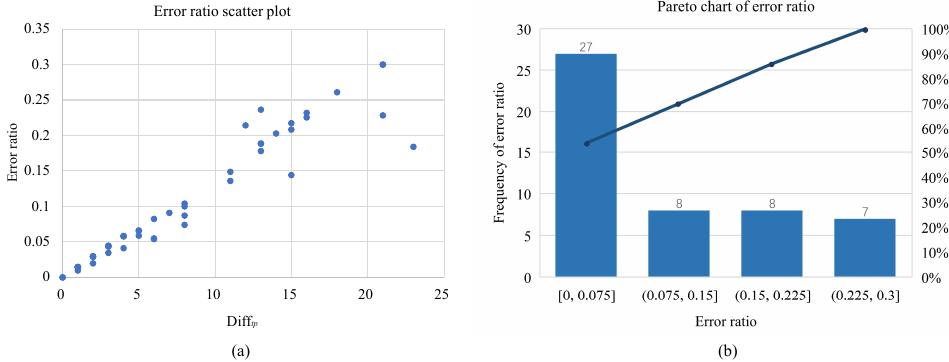
Figure 13. Results of error ratio. ( a ) Error ratio scatter plot. ( b ) Pareto chart of error